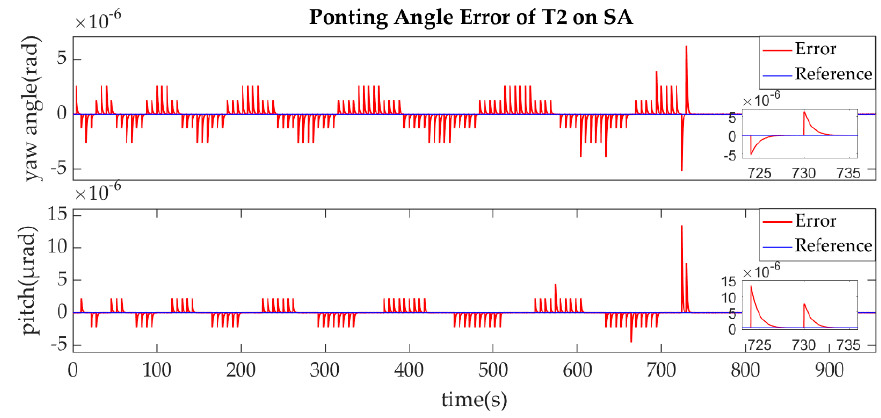
Figure 16. Ponting Angle Error of T2 on SA.